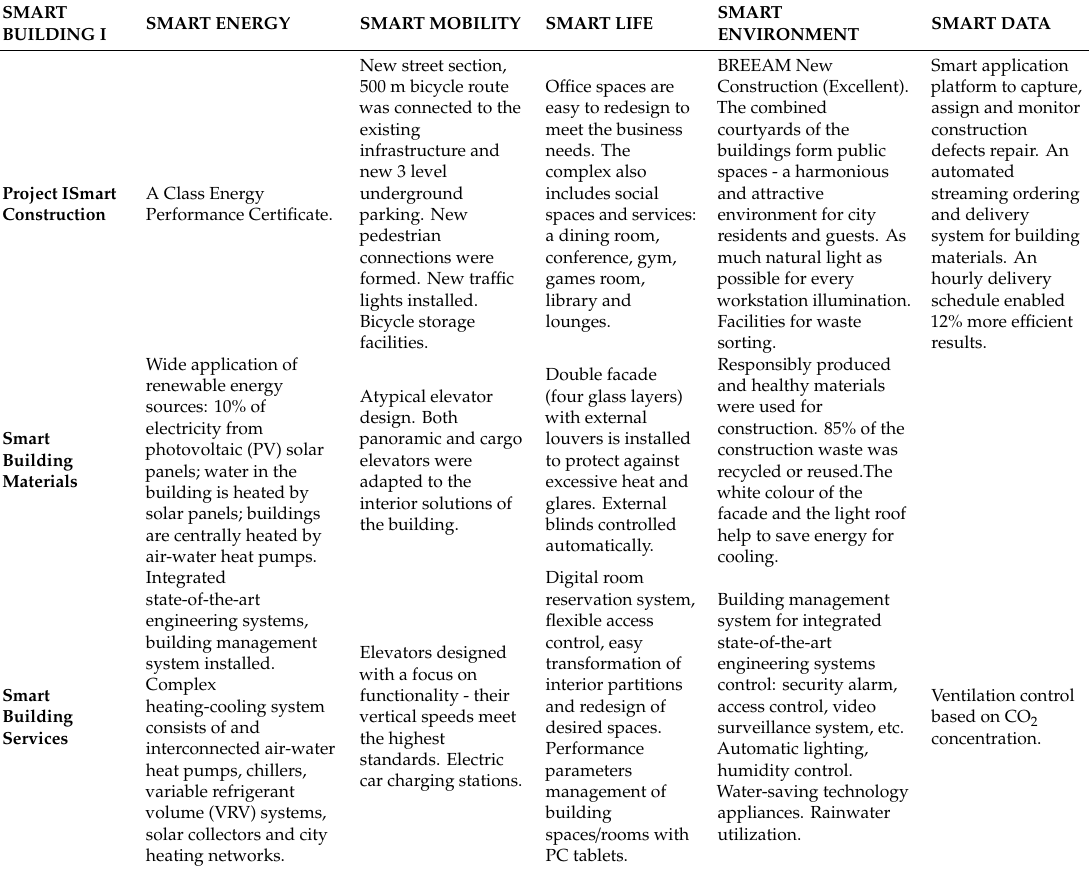
Table 12. Analysis of Smart Building I